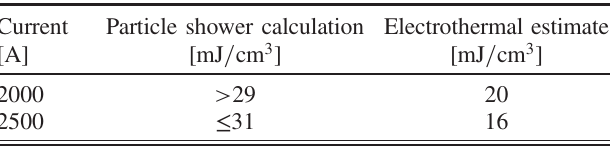
TABLE II. Quench-level comparison; FLUKA bounds and the electrothermal MQED estimate for the short-duration collimation quench